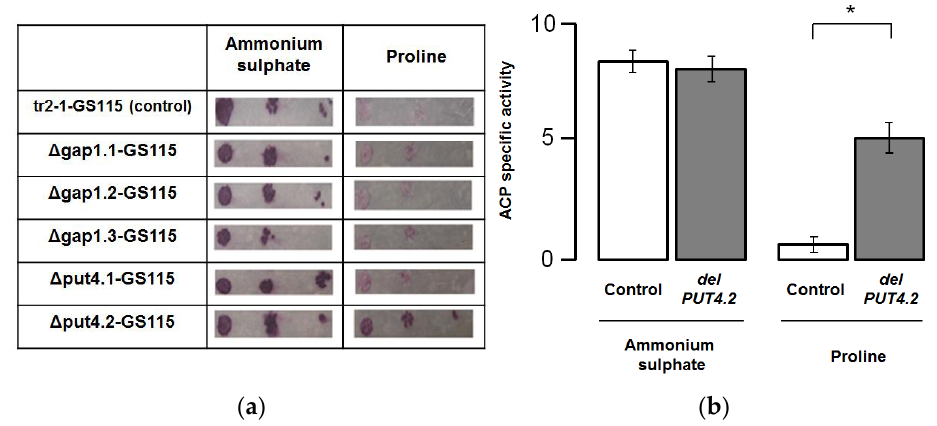
Figure 5. Effect of deletions in the K. phaffii permease genes on the activity of the PHO5 ACP reporter gene under the control of the AOX1 gene promoter: ( a ) results of qualitative analysis of ACP activity on the surface of the colonies of Δgap1.1-GS115, Δgap1.2-GS115, Δgap1.3-GS115, Δput4.1-GS115, Δput4.2-GS115 and control tr2-1-GS115 strains grown on plates with minimal media containing methanol in addition to either ammonium sulphate or proline; ( b ) analysis of ACP specific activity in the cultures of Δput4.2-GS115 and control tr2-1-GS115 strains after growth and methanol induction in media with ammonium sulphate or proline. The mean with SEM from four separate experiments with two technical replications is presented (* p < 0.05; Mann–Whitney U test).